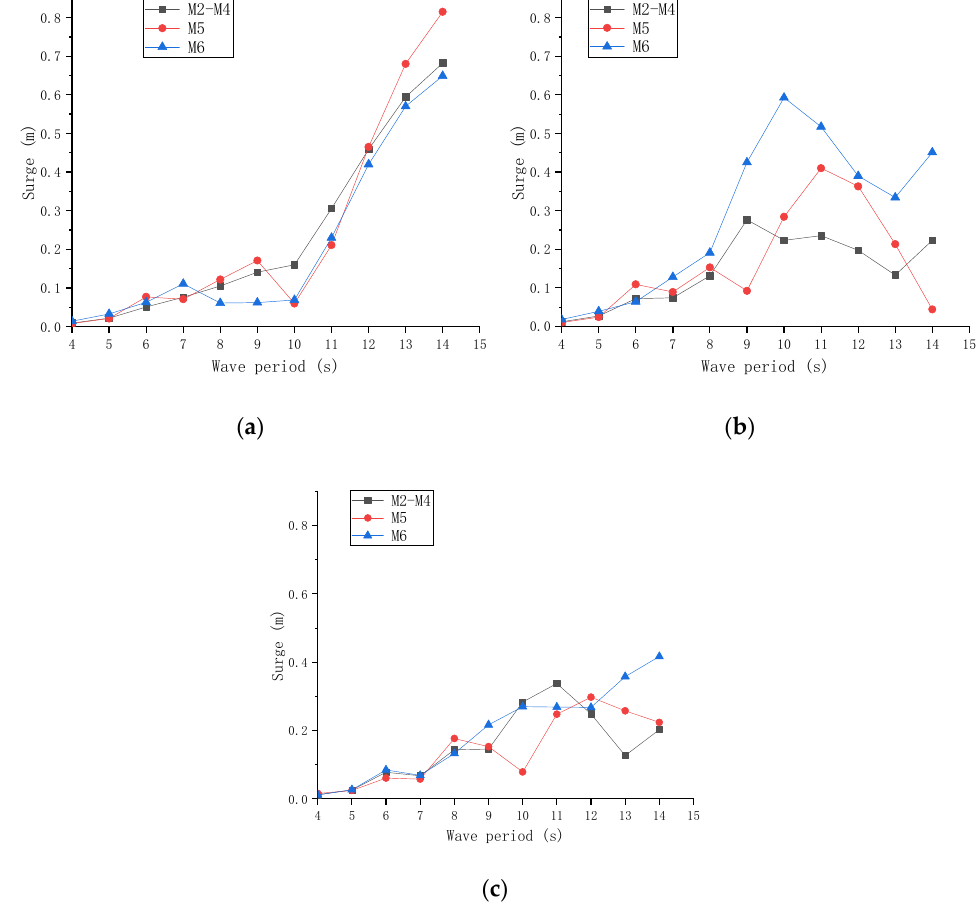
Figure 9. Surge of three expansion schemes: ( a ) Scheme A; ( b ) Scheme B; ( c ) Scheme C.